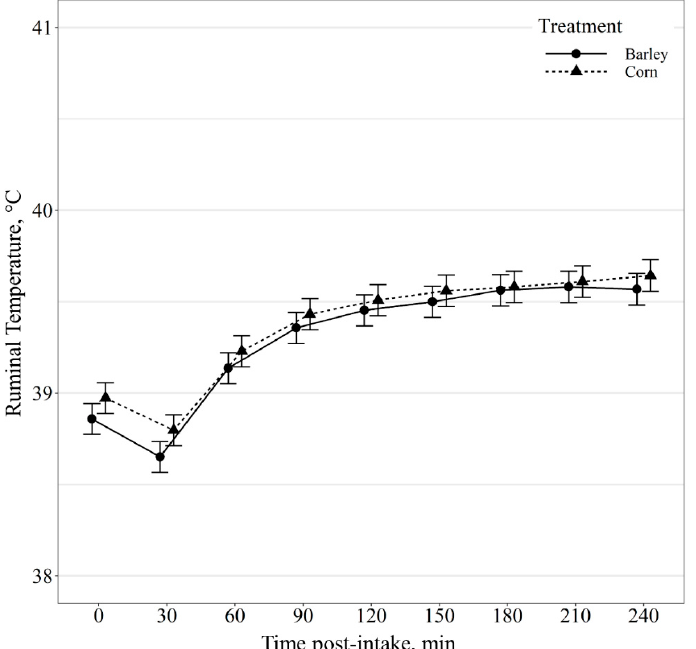
Figure 7. Ruminal temperature (°C) change as a function of time (min) relative to intake event of beef steers provided barley- or corn-based feedlot diets. Ruminal temperature was influenced by a diet × minute post-intake event interaction ( p < 0.01); however, no differences ( p ≥ 0.11) were observed between diets within post-intake event time periods.